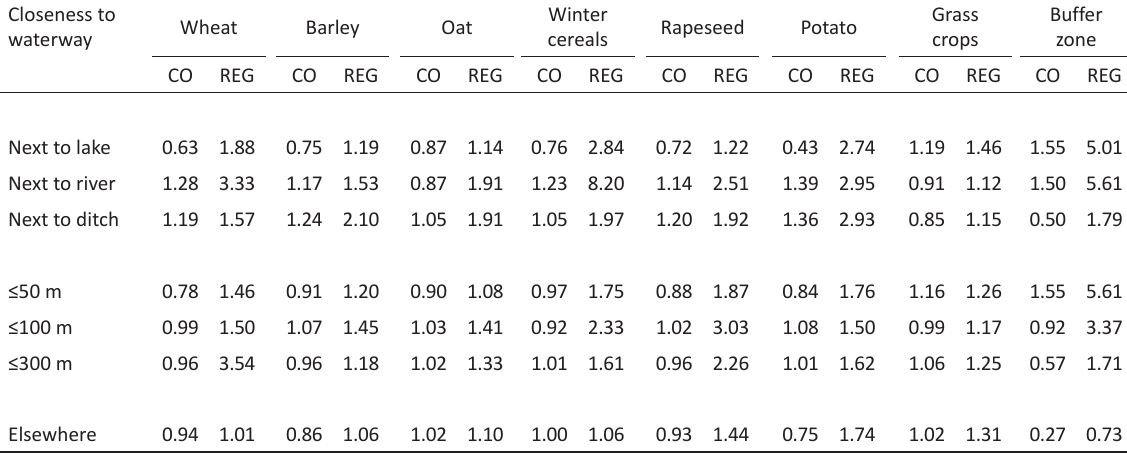
Table 1. Percentage of crop grown in fields close to waterways and elsewhere compared with general cropping percentage (% / %) at national (CO) level and in the region (REG) with the highest percentage (i.e., 1.00 refers to equal percentage at national scale, <1.00 lower percentage and >1.00 higher percentage compared with national or regional scale). Also proportion of fields with buffer zones (%) (area being at least 15 m from shoreline) incentivized by the Agri-Environmental Program is shown at national and regional scale. Data for 2011 provided by